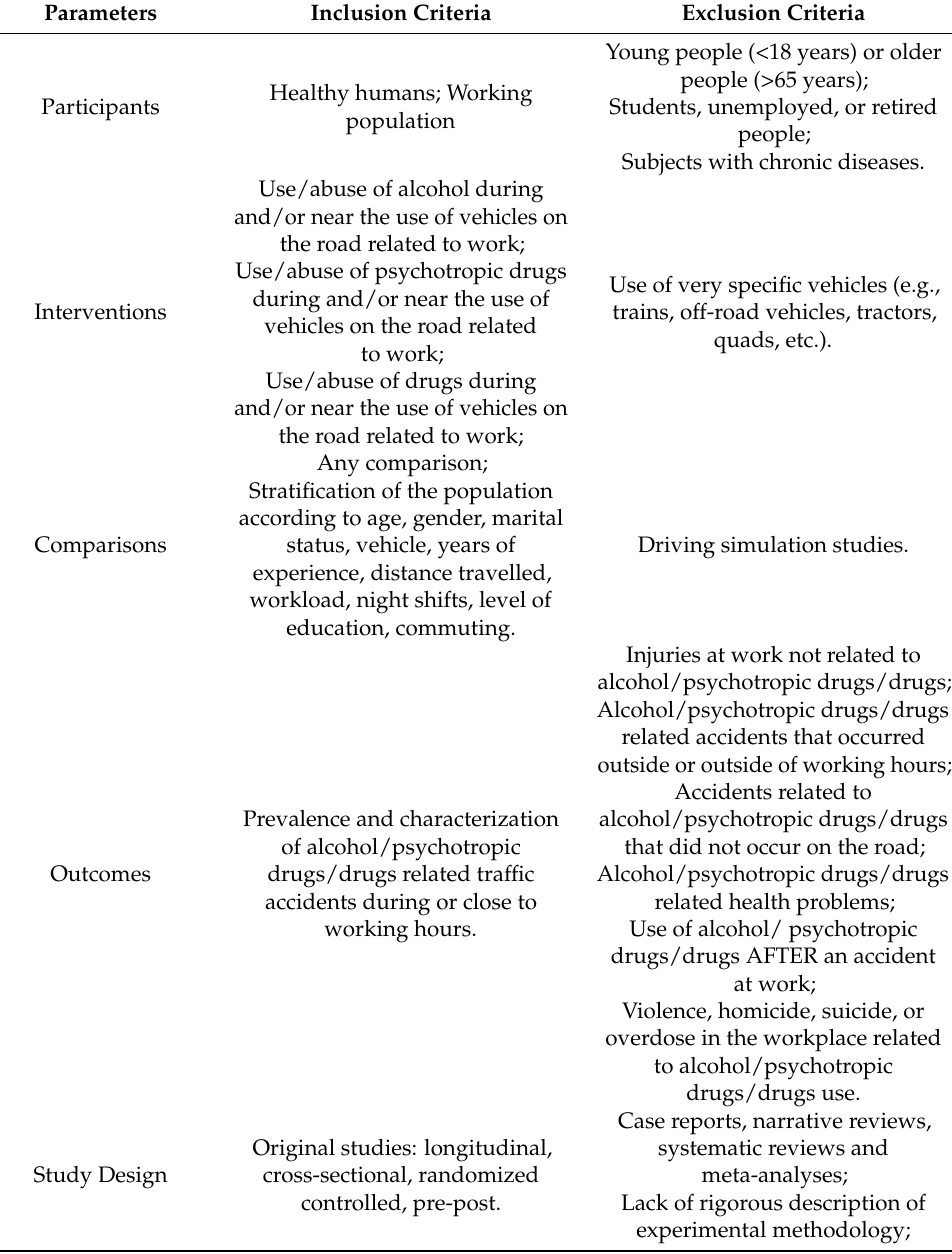
Table 2. Participants, Interventions, Comparisons, Outcomes, and Study Design